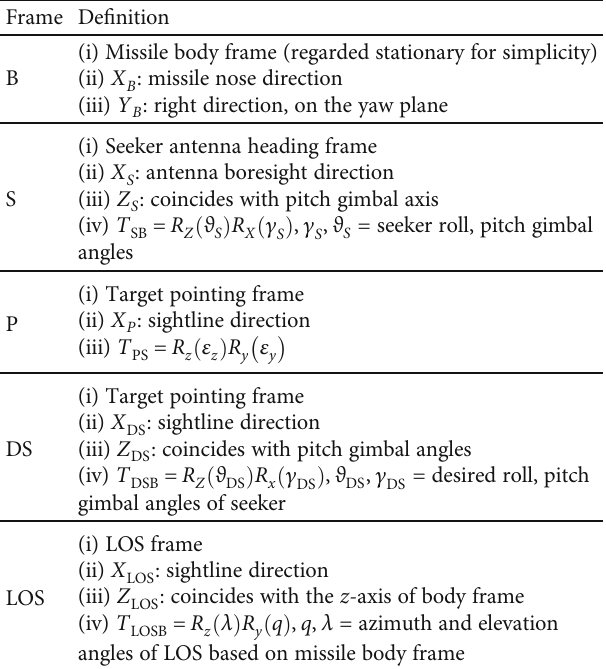
Table 1: De fi nitions of coordinate